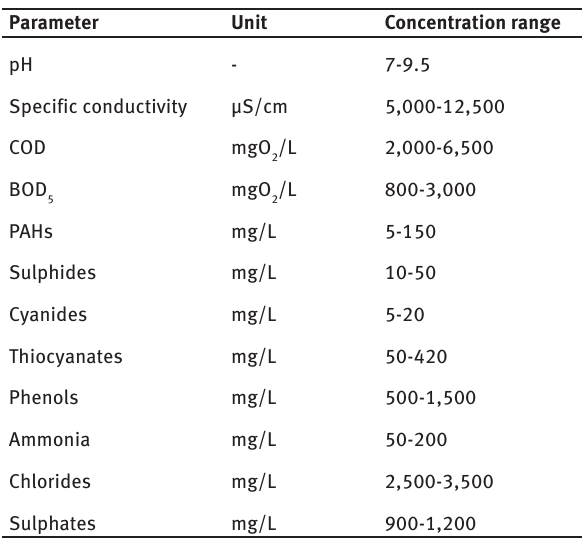
Table 1: Typical composition of raw coke oven